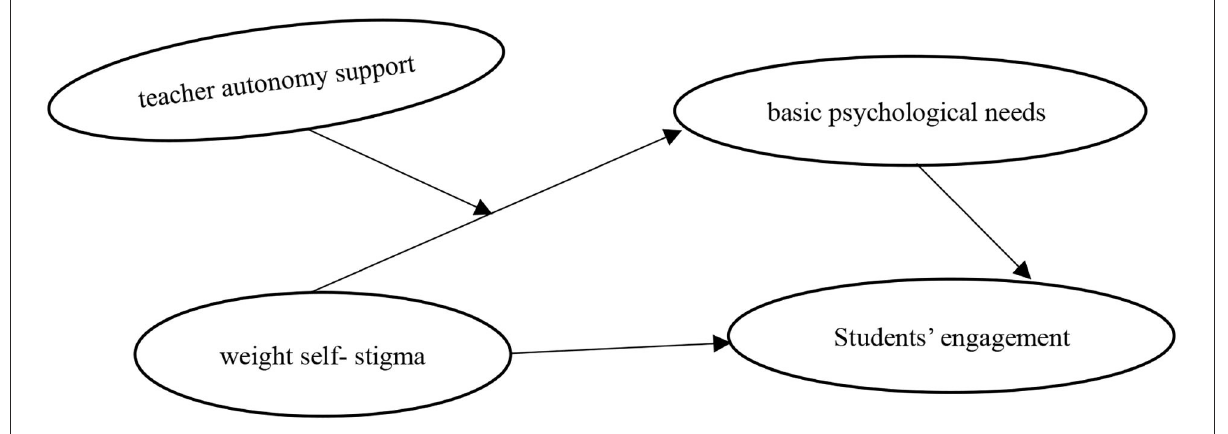
FIGURE1 The hypothesized model.